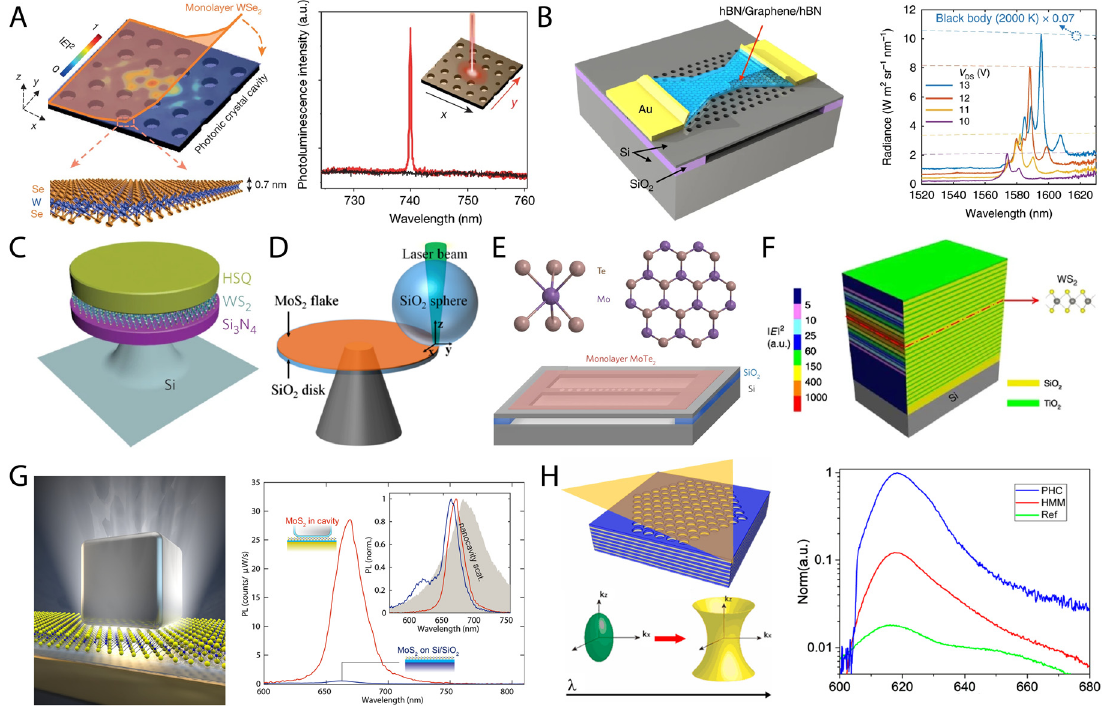
Figure 2: Enhancing optical emission by controlling the photonic density of states